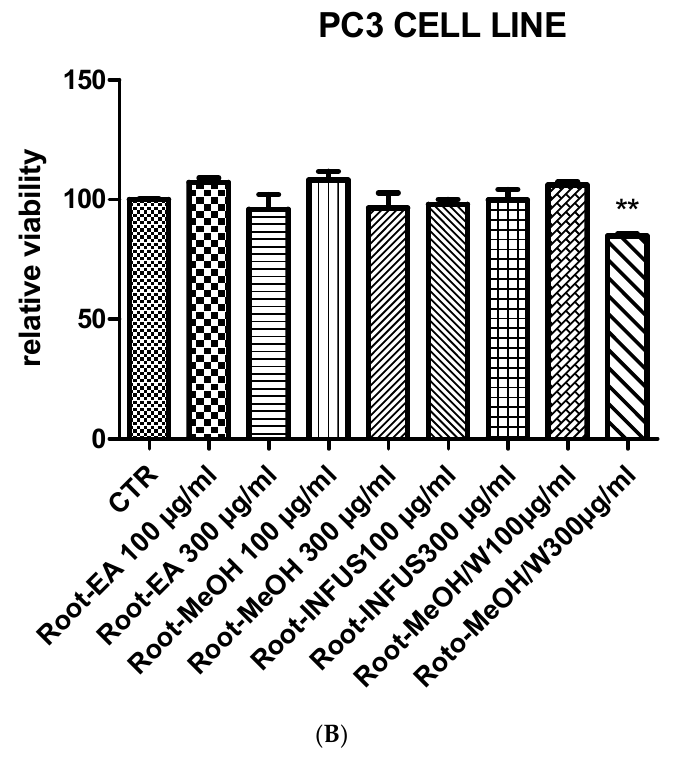
Figure 1. Antiproliferative effects induced by the methanol (MeOH), ethyl acetate (EA), water (in- fusion), methanol/water (MeOH/W) extracts of the aerial parts (AP) ( A ) and roots ( B ) from Epilobium hirsutum (100–300 µg/mL). ANOVA, p < 0.0001, ** p < 0.01, *** p < 0.001 vs. CTR (Control) group.